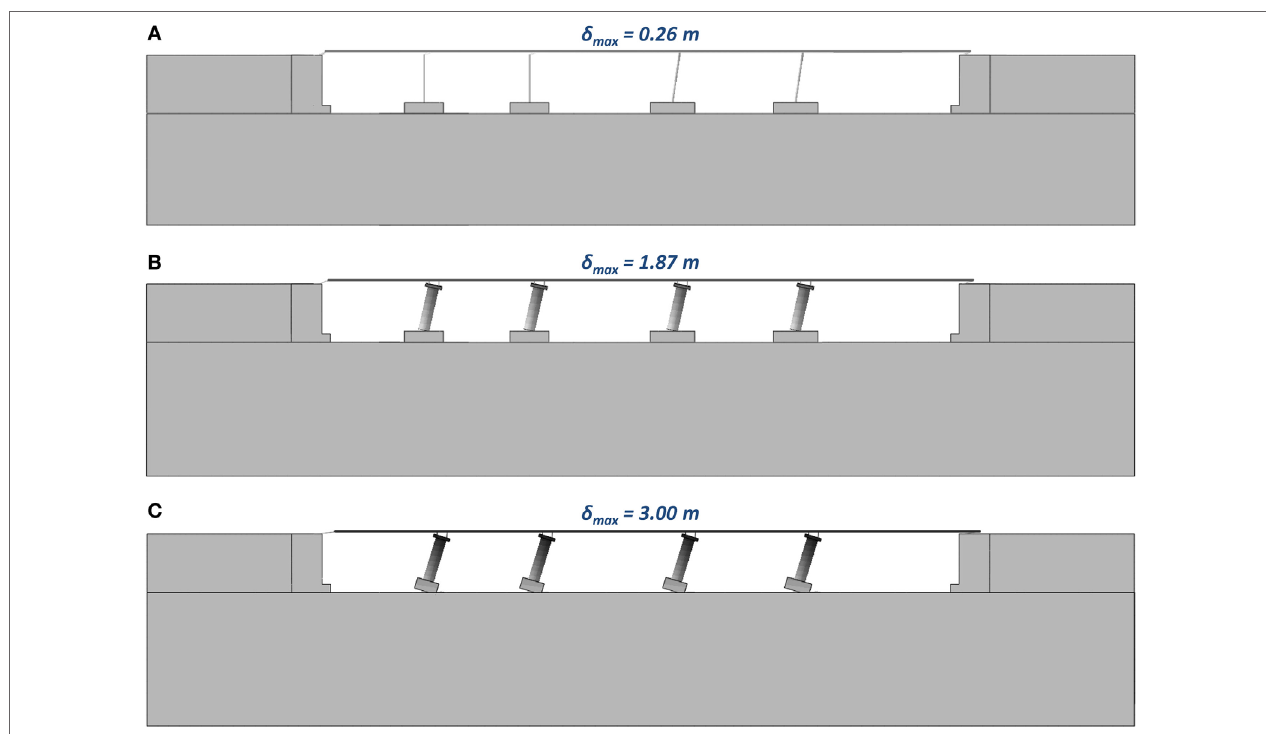
FigUre 6 | Snapshots of the examined systems at incipient collapse showing contours of total displacement during static pushover analysis in the longitudinal direction for: (a) conventional design; (B) rocking piers; and (c) rocking